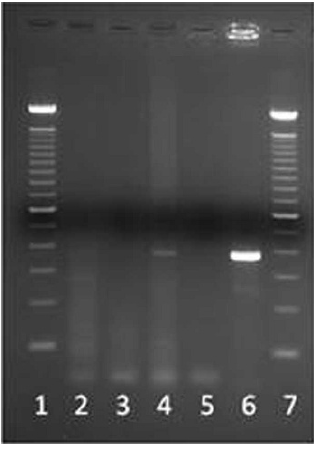
Figure 3 - 2% agarose gel. PCR was performed with specific primers for Mycobacterium sp. (17), whose amplicon is 383 bp. Columns: 1 and 7, 100-bp marker; 2, negative control (without DNA); 3, paraffin biopsy of skin vasculitis; 4, paraffin sample of a cervical lymph node; 5, culture of M. avium complex; and 6, culture of M. tuberculosis . PCR was positive for M. tuberculosis culture and the cervical lymph node (site of infection) and negative for the skin